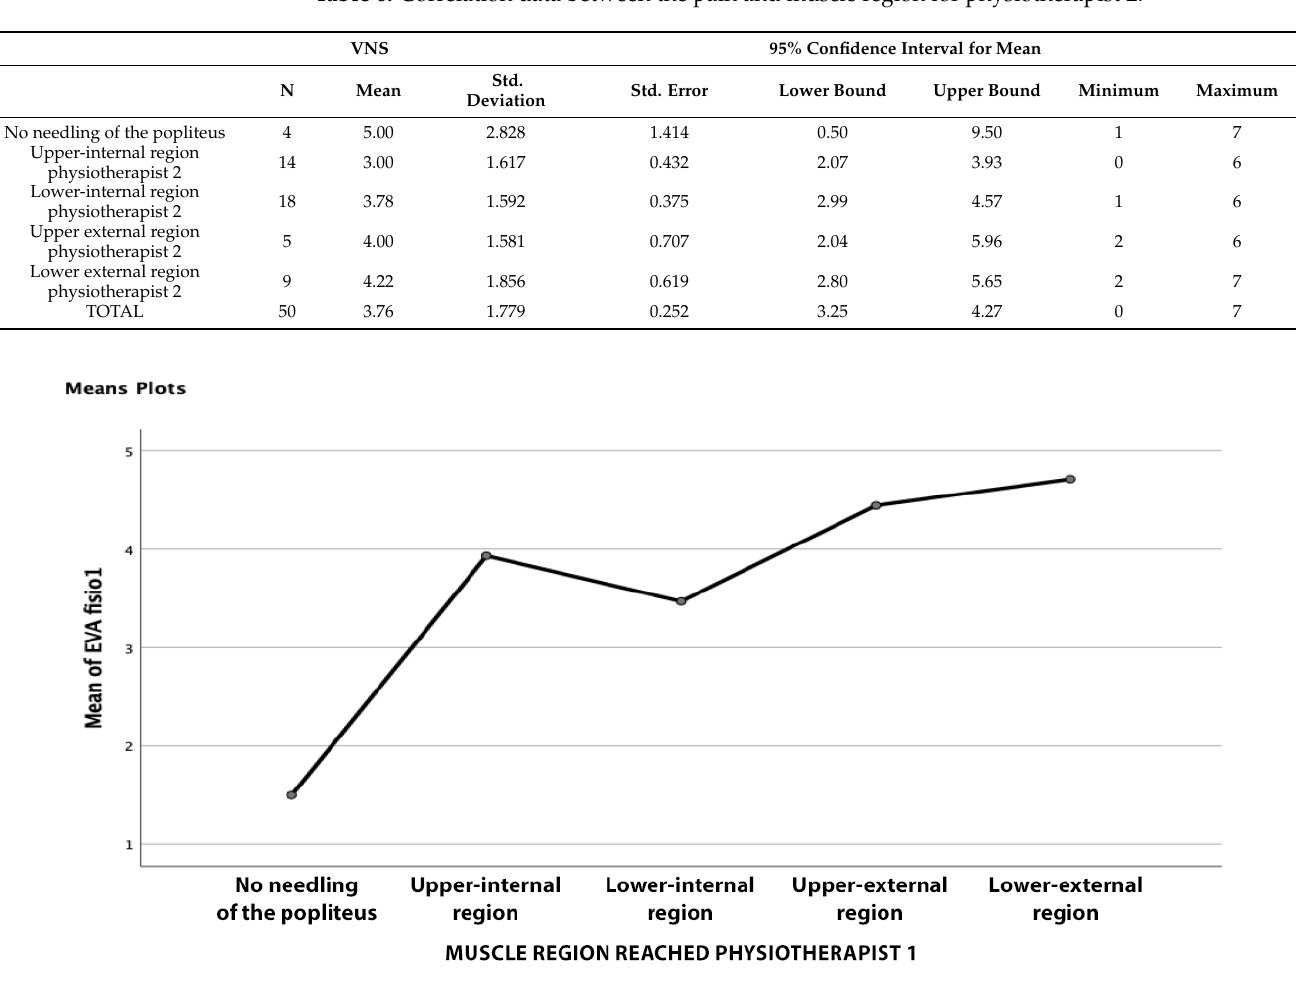
Figure 8. Line graph of the relationship between the VNS and punctured muscle region physiotherapist 1 . Table 6. Correlation data between the pain and muscle region for physiotherapist 2.